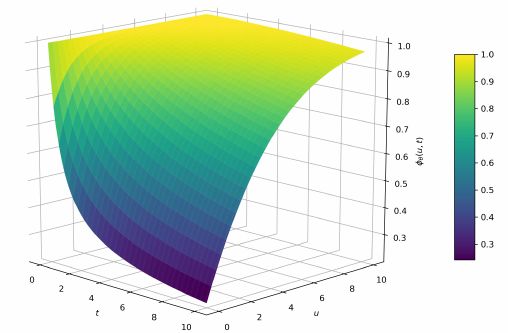
Figure 4. The DNN approximation solution for parameter 1.